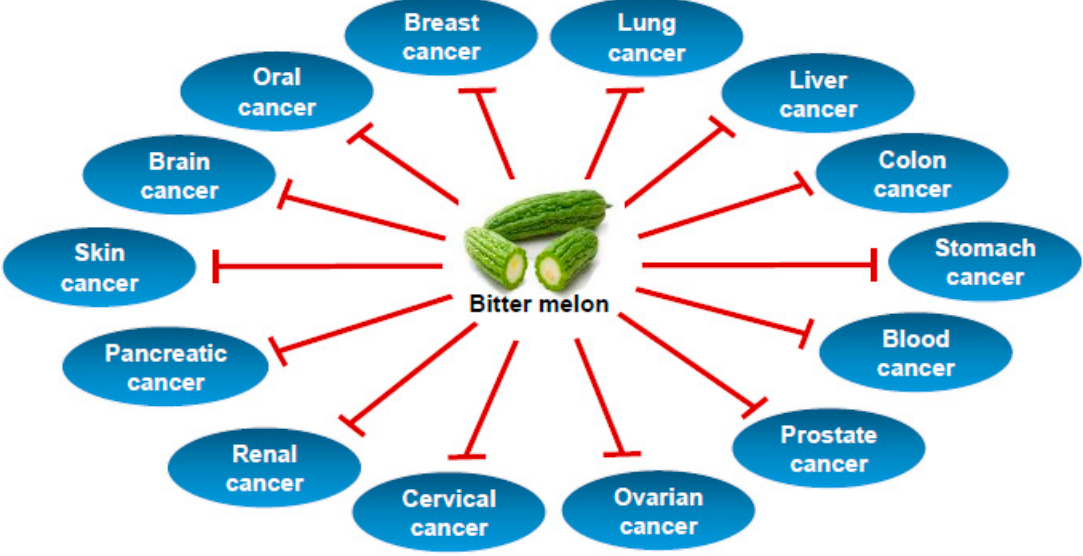
Figure 2. Types of cancer prevented by bitter melon.